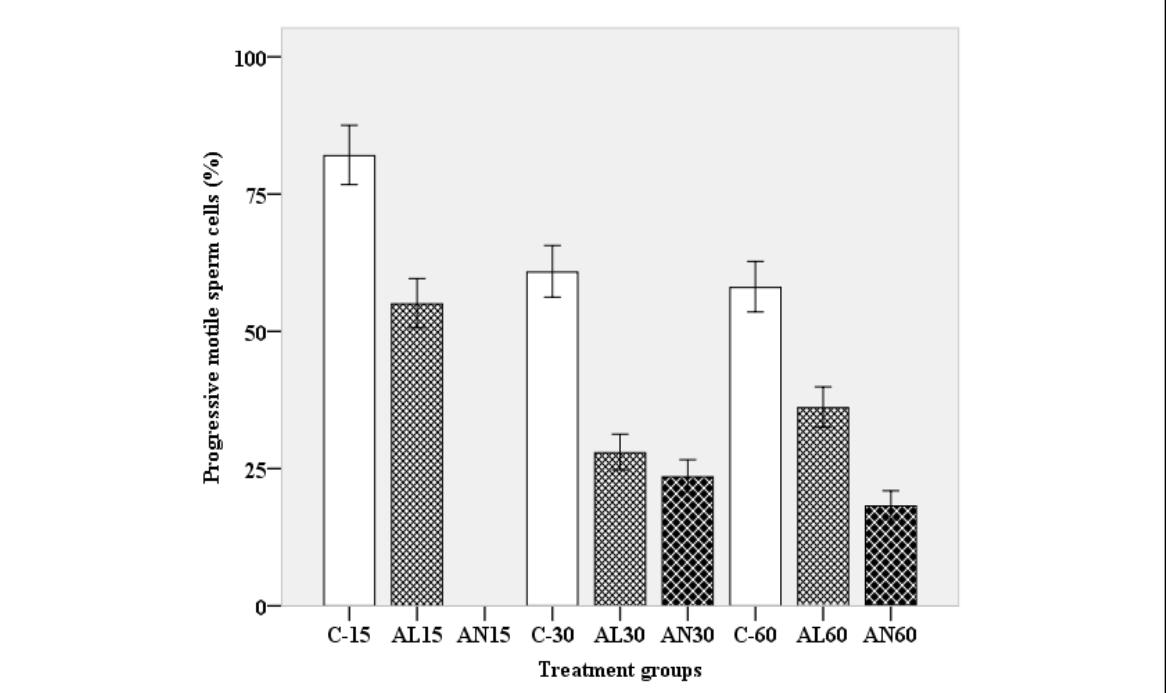
Figure 2: Effect of crude plant extract in feed on the percentages of progressively motile sperm cells following its treatment for 15, 30 or 60 days in the M. natalensis male rats. C = control groups, AL= A. lebbeck stem bark methanolic extracts, AN = A. nilotica pods methanolic extracts. Pearson chi-squared test; treatment groups (  2 = 453.98, df = 2, p < 0.001), treatment duration (  2 = 157.30, df = 2, p <